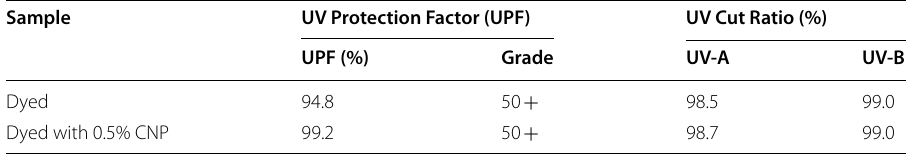
Table 6 UV protection rate of cotton dyed with Euphorbia with and without cellulose nanoparticles (CNP)